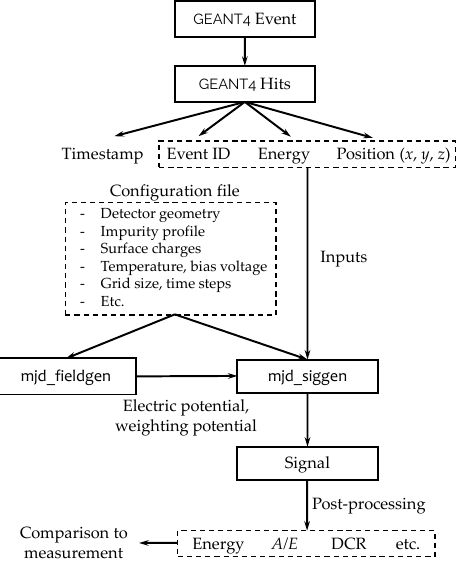
Figure 17. Flow diagram of the surface event